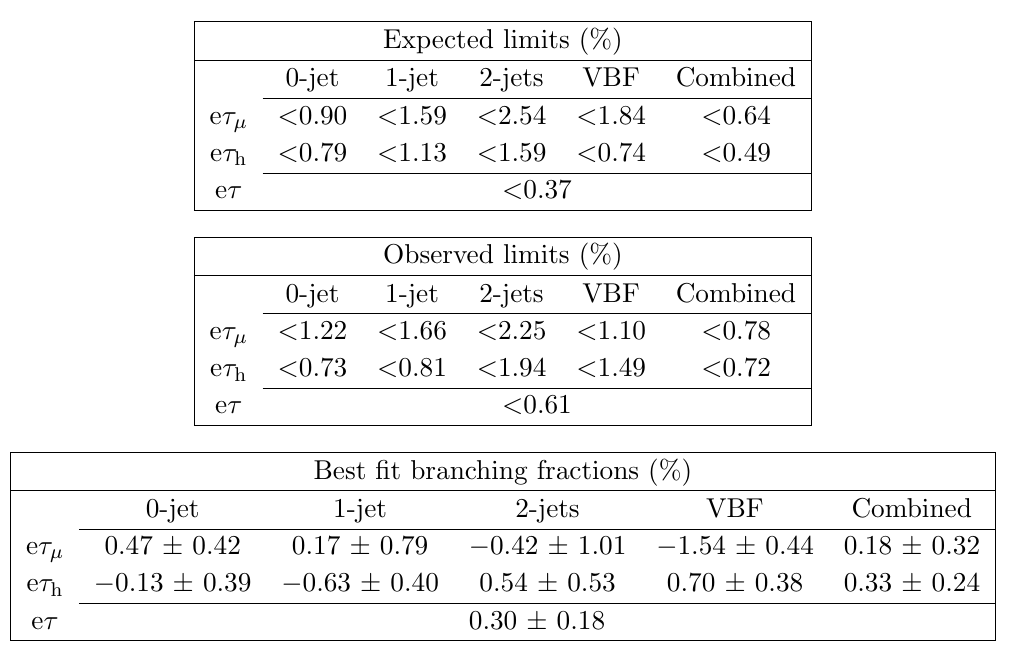
Table 6 . Expected and observed upper limits at 95% CL and best (cid:12)t branching fractions in percent for each individual jet category, and combined, in the H ! e (cid:28) process obtained with the BDT (cid:12)t